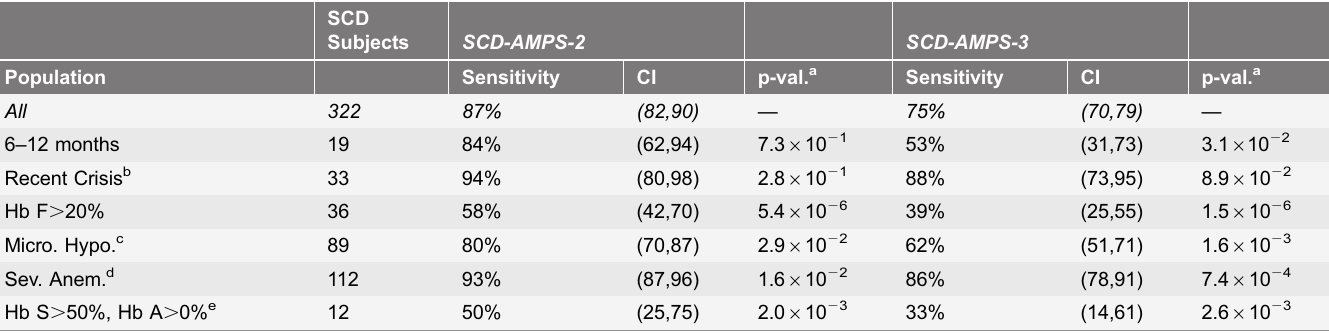
Table 4. Sensitivity of SCD-AMPS tests on specific